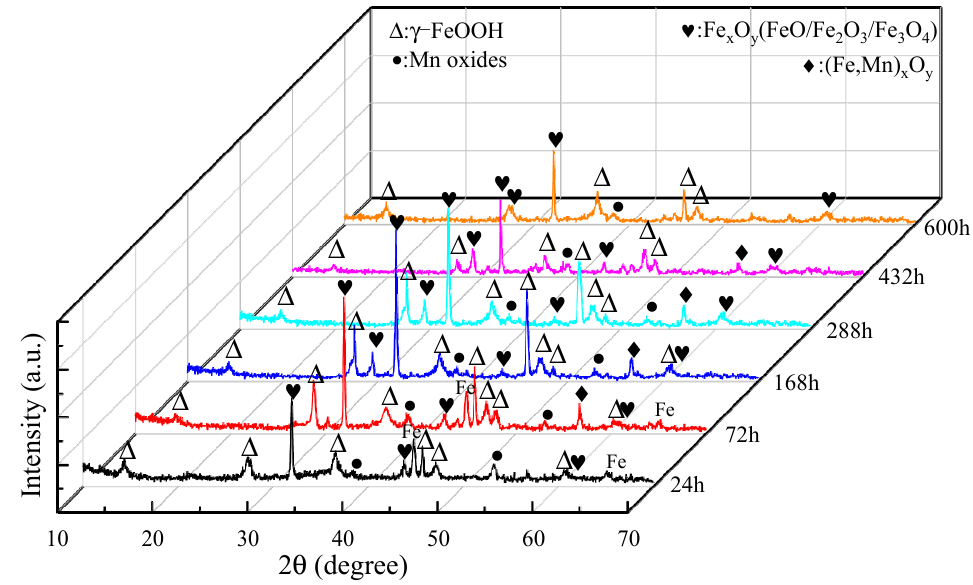
Figure 3. XRD diffraction patterns of corrosion products.